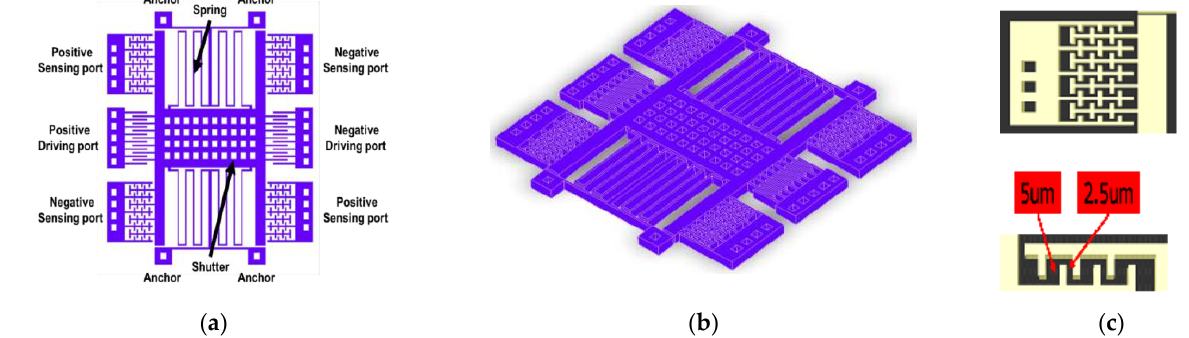
Figure 6. ( a ) Top view with illustration; ( b ) oblique view of MEMS oscillator; ( c ) fingers on each side and distance of gaps between stator and rotor.